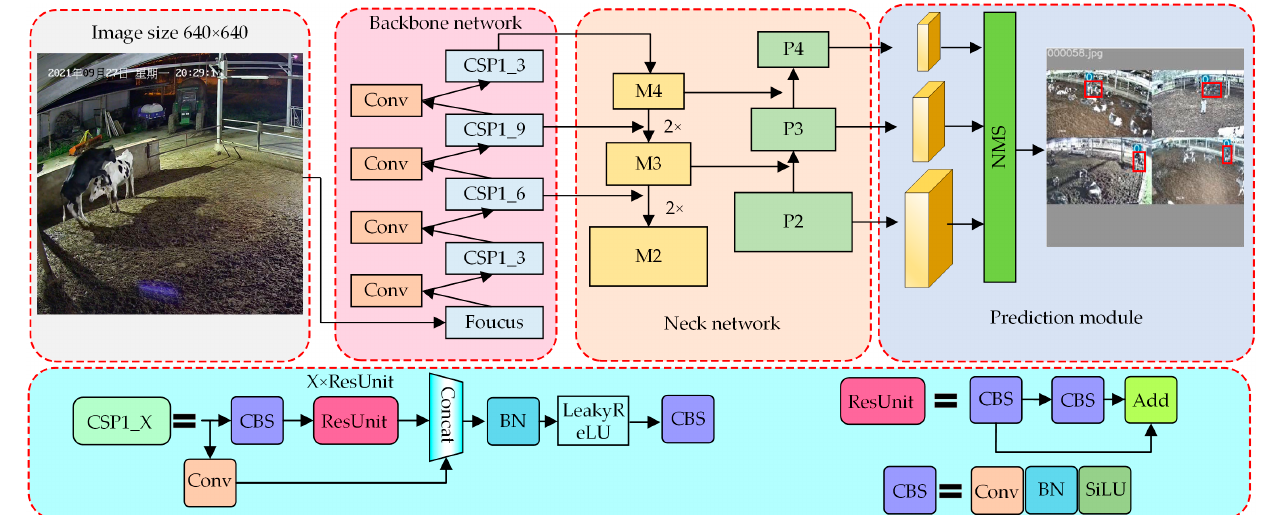
Figure 4. Network structure of YOLOv5.